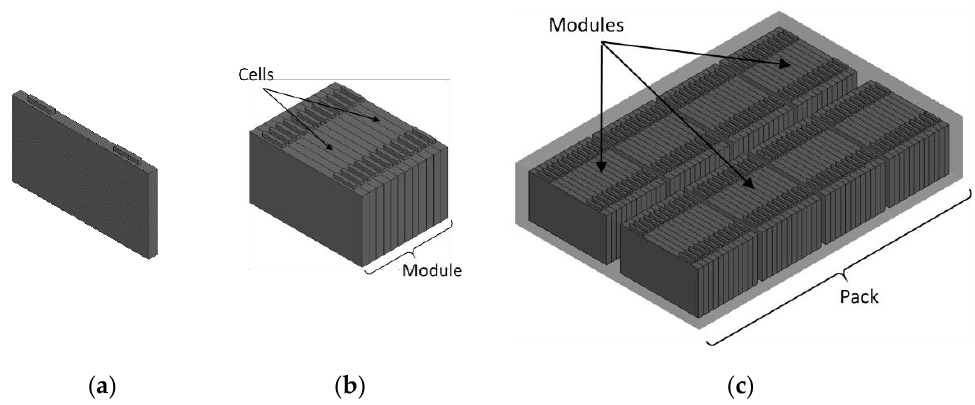
Figure 1. Battery levels: ( a ) battery cell; ( b ) battery module; ( c ) battery pack.